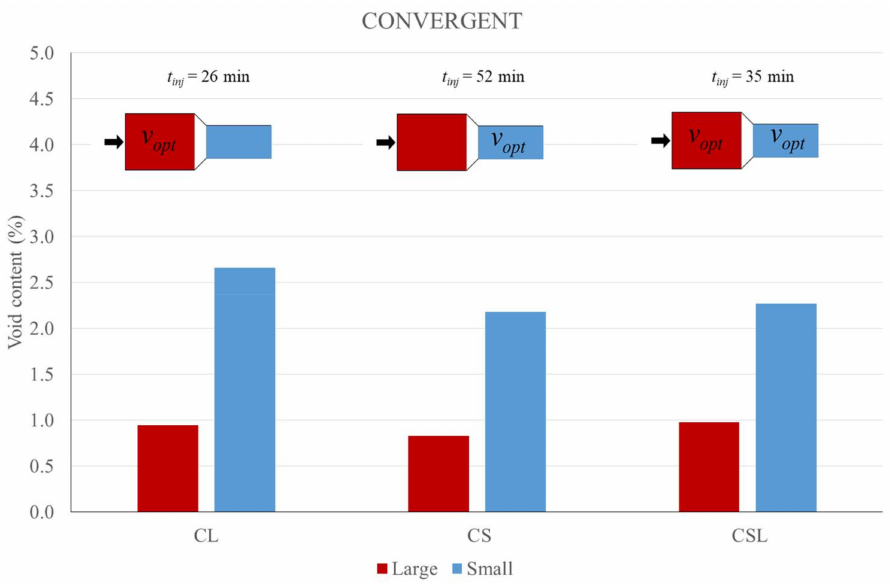
Figure 13. Void content analysis averaged by section for the convergent